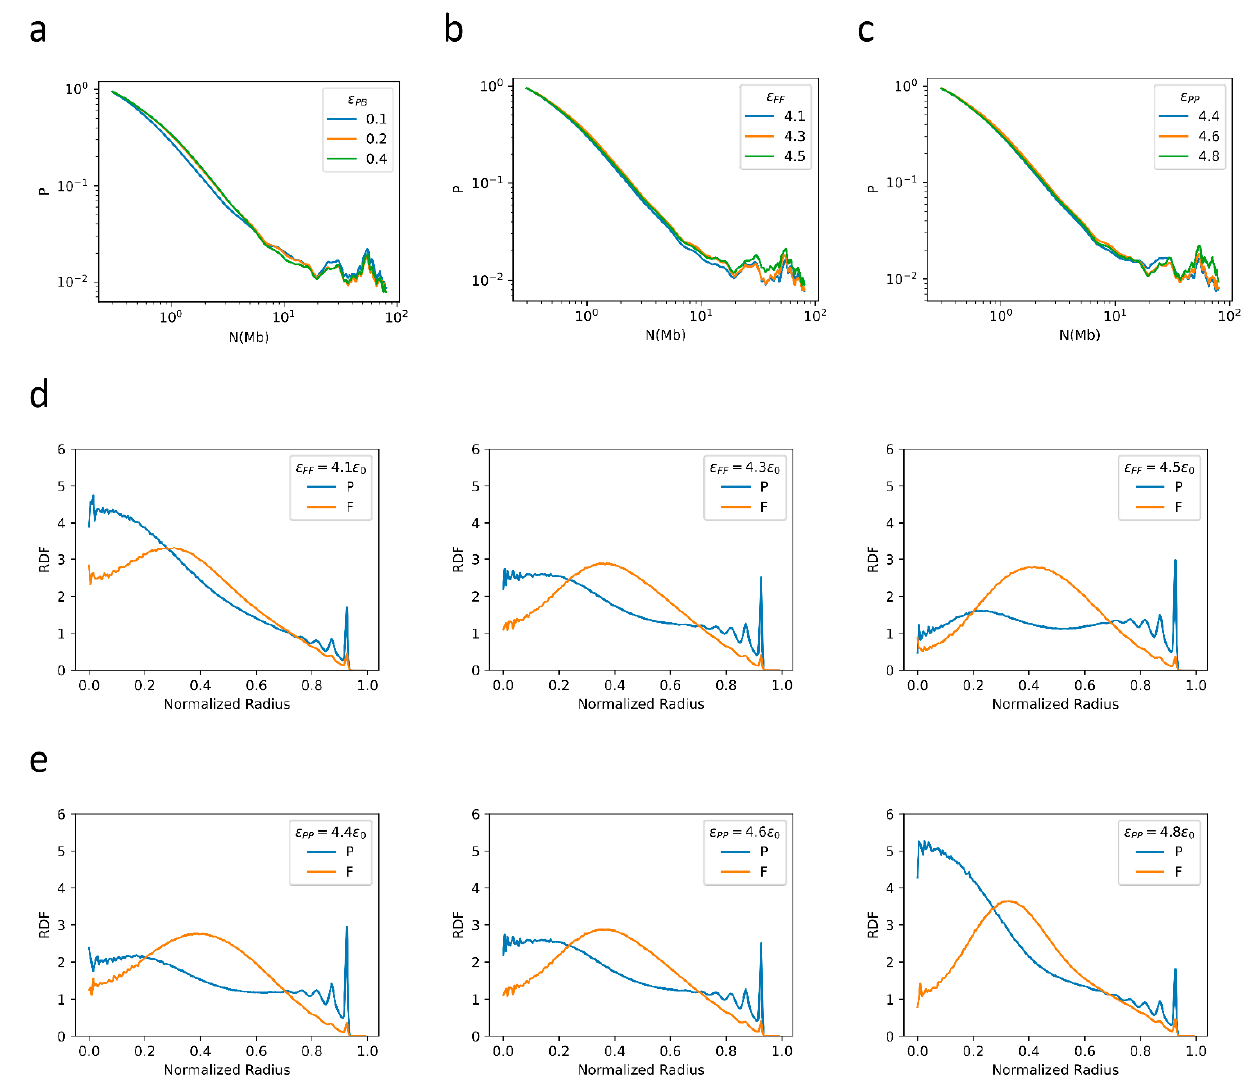
Figure 4. ( a ) the contact probability generated from the 1-Chr system with different ε PB values as a function of sequential distance; ( b ) the contact probability generated from the 1-Chr system with different ε FF values as a function of sequential distance; ( c ) the contact probability generated from the 1-Chr system with different ε PP values as a function of sequential distance; ( d ) the RDFs obtained from the 1-Chr system with different ε FF values; ( e ) the RDFs obtained from the 1-Chr system with different ε PP values.